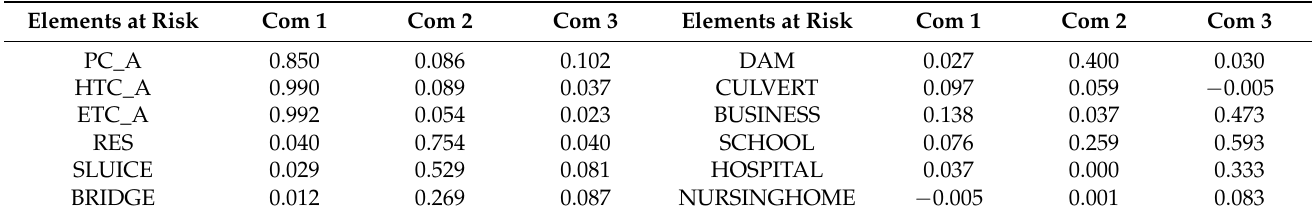
Table 8. Results of Analysis of Elements at